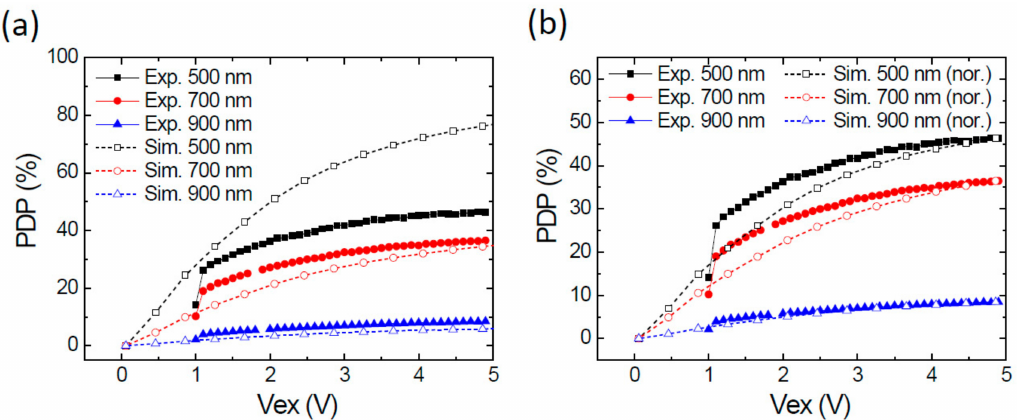
Figure 9. Bias-dependent PDP at the wavelengths of 500, 700, and 900 nm. ( a ) Measured and simulated PDP; ( b ) Original measured PDP and simulated PDP normalized with the corresponding PDP at Vex = 5.0